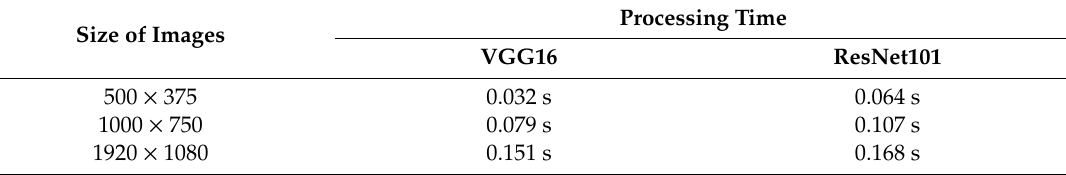
Table 3. Processing time of a GeForce GTX 1080 Ti graphic card for different image sizes and feature extractors.